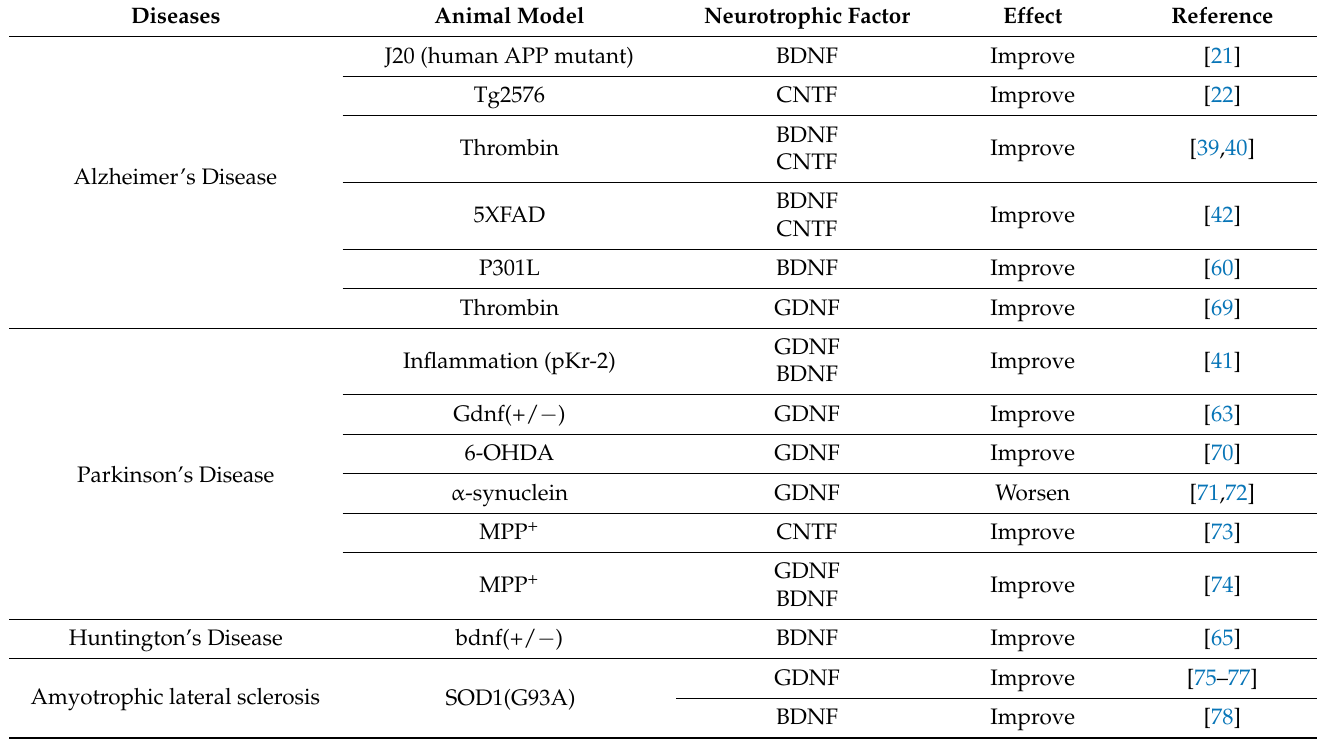
Table 2. Animal model used to study the therapeutic effect of neurotrophic factors in various neurodegenerative